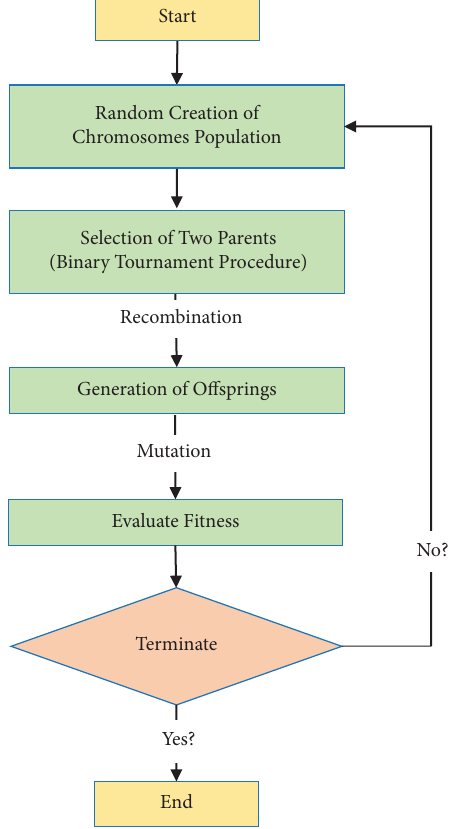
Figure 4: Working mechanism of a typical multiexpression pro- gramming modelling approach